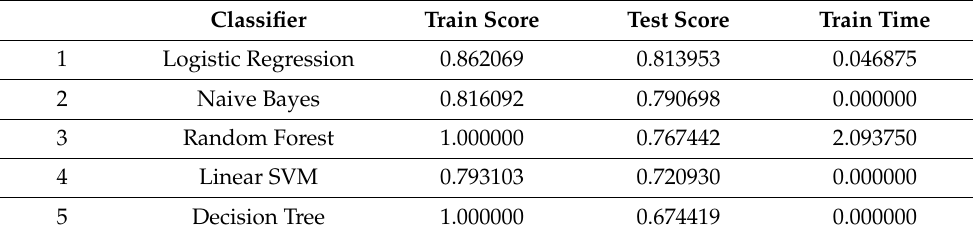
Table 5. Accuracy of five classifiers. The test score values represent the performance of the various models. The model with the highest test score is to be considered the best performing.